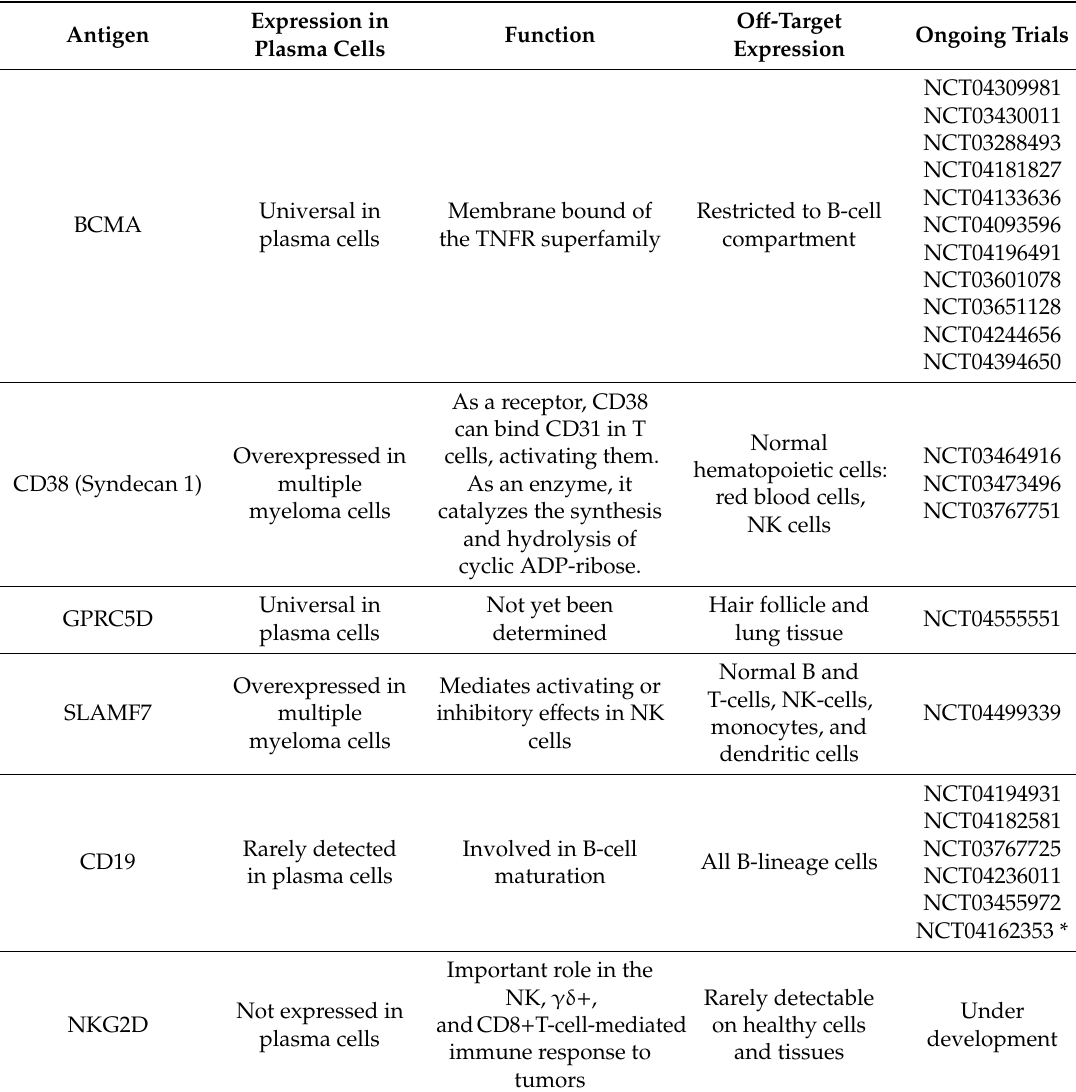
Table 1. Summary of potential targets for CAR T-cell development including patterns of expression and reference to ongoing / planned clinical